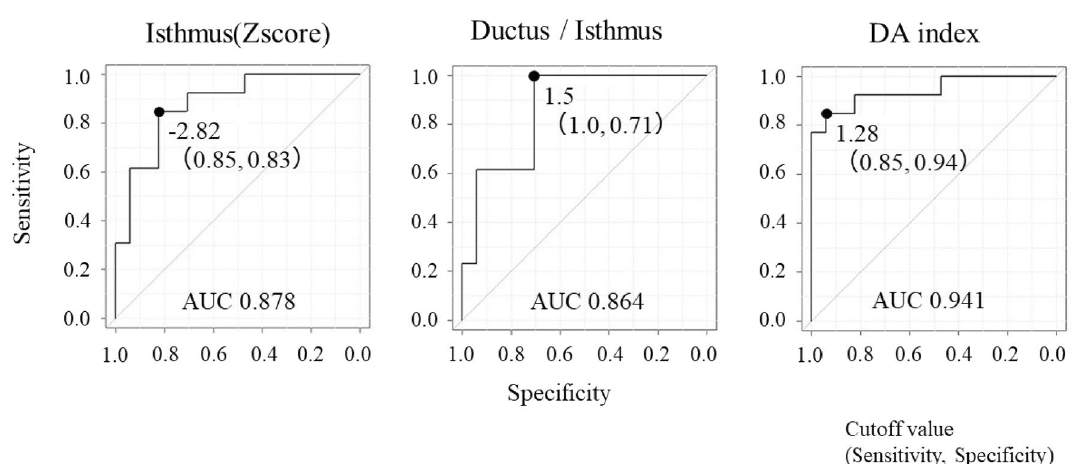
Figure 3. ROCs of three parameters with significant differences. ROC using the DA index had a sensitivity of 85% and specificity of 94% (AUC = 0.941). The optimal and most effective cutoff value is 1.28 when using the DA index to predict coarctation of the aorta fetuses. ROC receiver operating characteristic curves, DA distal aortic arch, AUC area under the